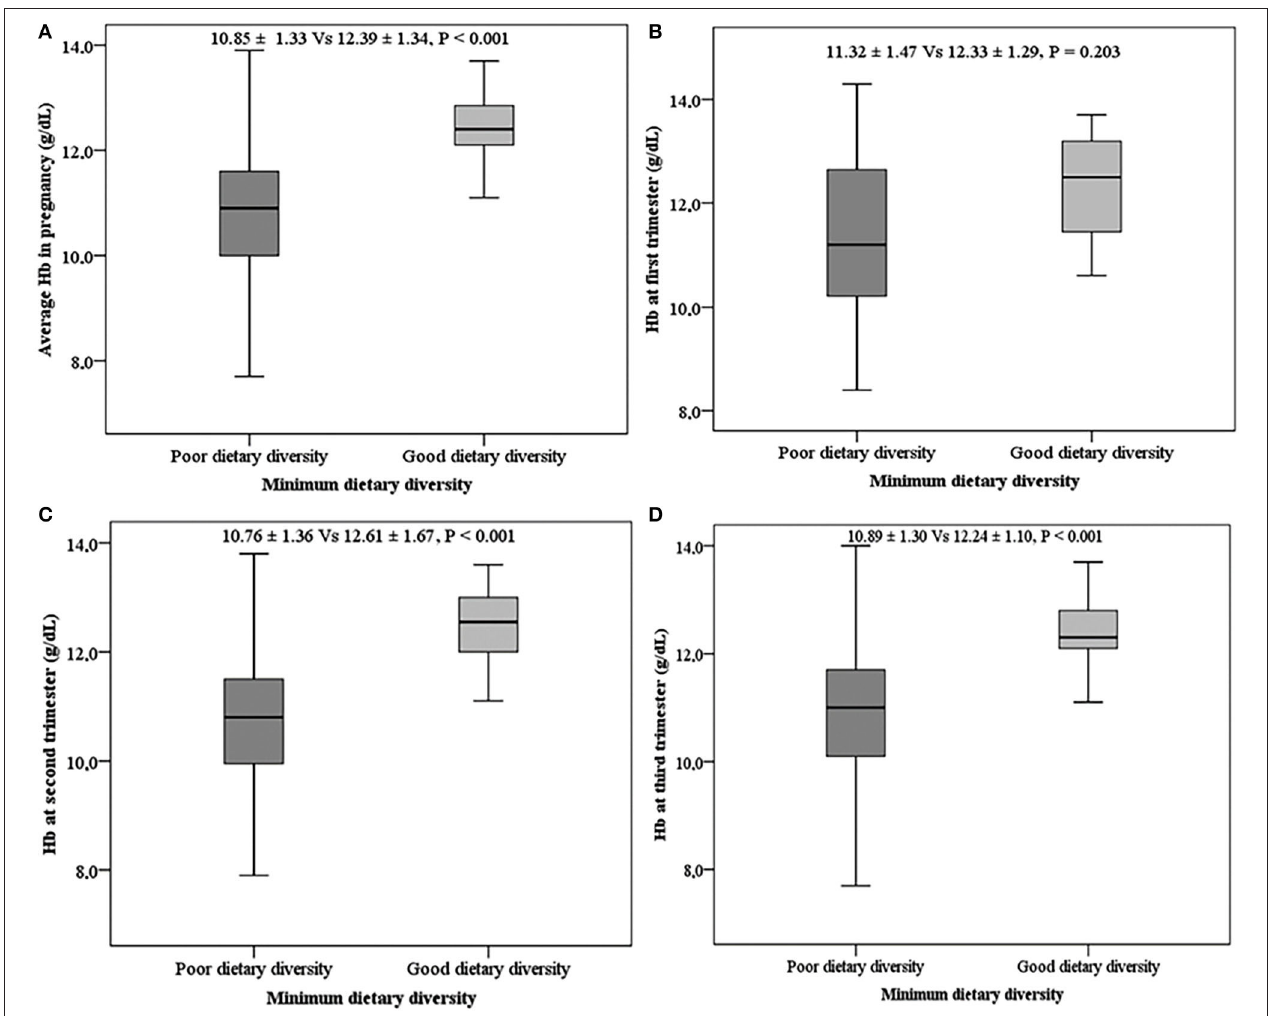
FIGURE 3 | Mean hemoglobin levels with respect to dietary diversity. (A) Mean Hb during pregnancy, (B) mean Hb in the first trimester, (C) mean Hb in the second trimester, (D) mean Hb in the third